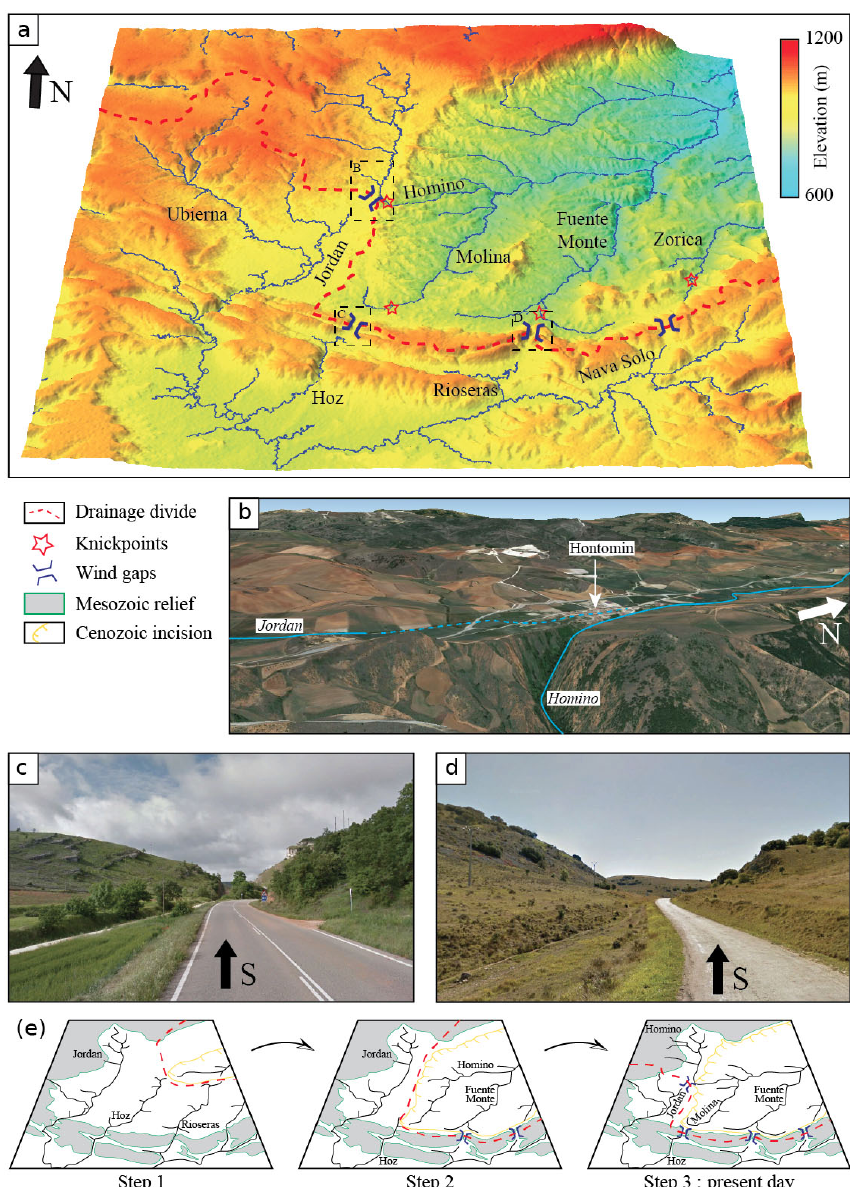
Figure 7. (a) Three-dimensional view of the DEM of the Bureba sector showing important contrast of incision between the Ebro and Duero basins across their divide (red dashed line) and river capture evidence (elbows of capture, knickpoints, and wind gaps). (b) Google Earth image around the locality of Hontomin where the Homino River is capturing the upper reach of the Jordan River. (c, d) Wind gaps cut into the Bureba anticline (see location on a ). Pictures have been taken from the north of this structure toward the south. (e) Possible three steps of evolution of the southwestward divide retreat through multiple river captures witnessed in the